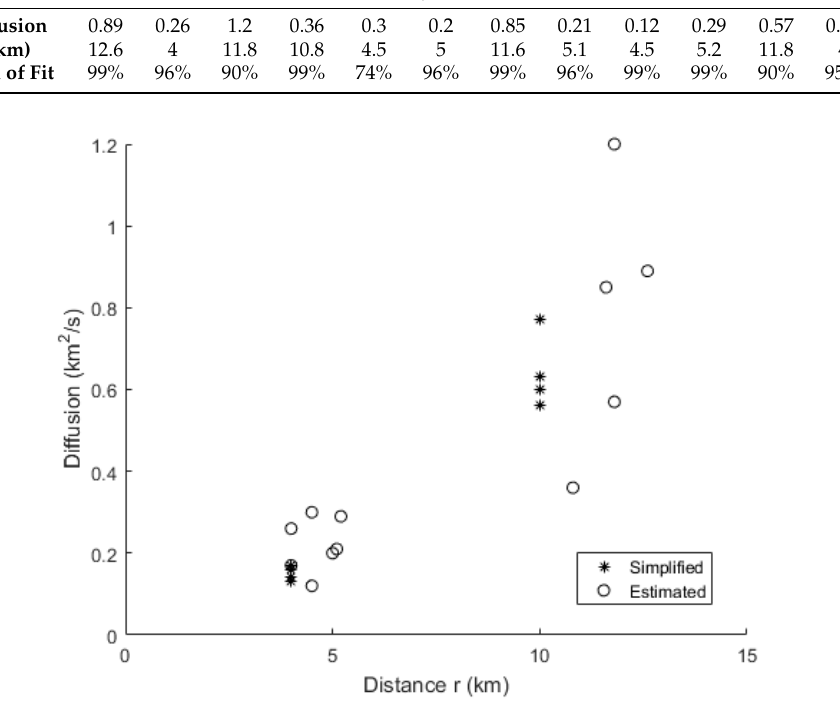
Figure 9. Plot of diffusion coefficient values against source-receiver offset.